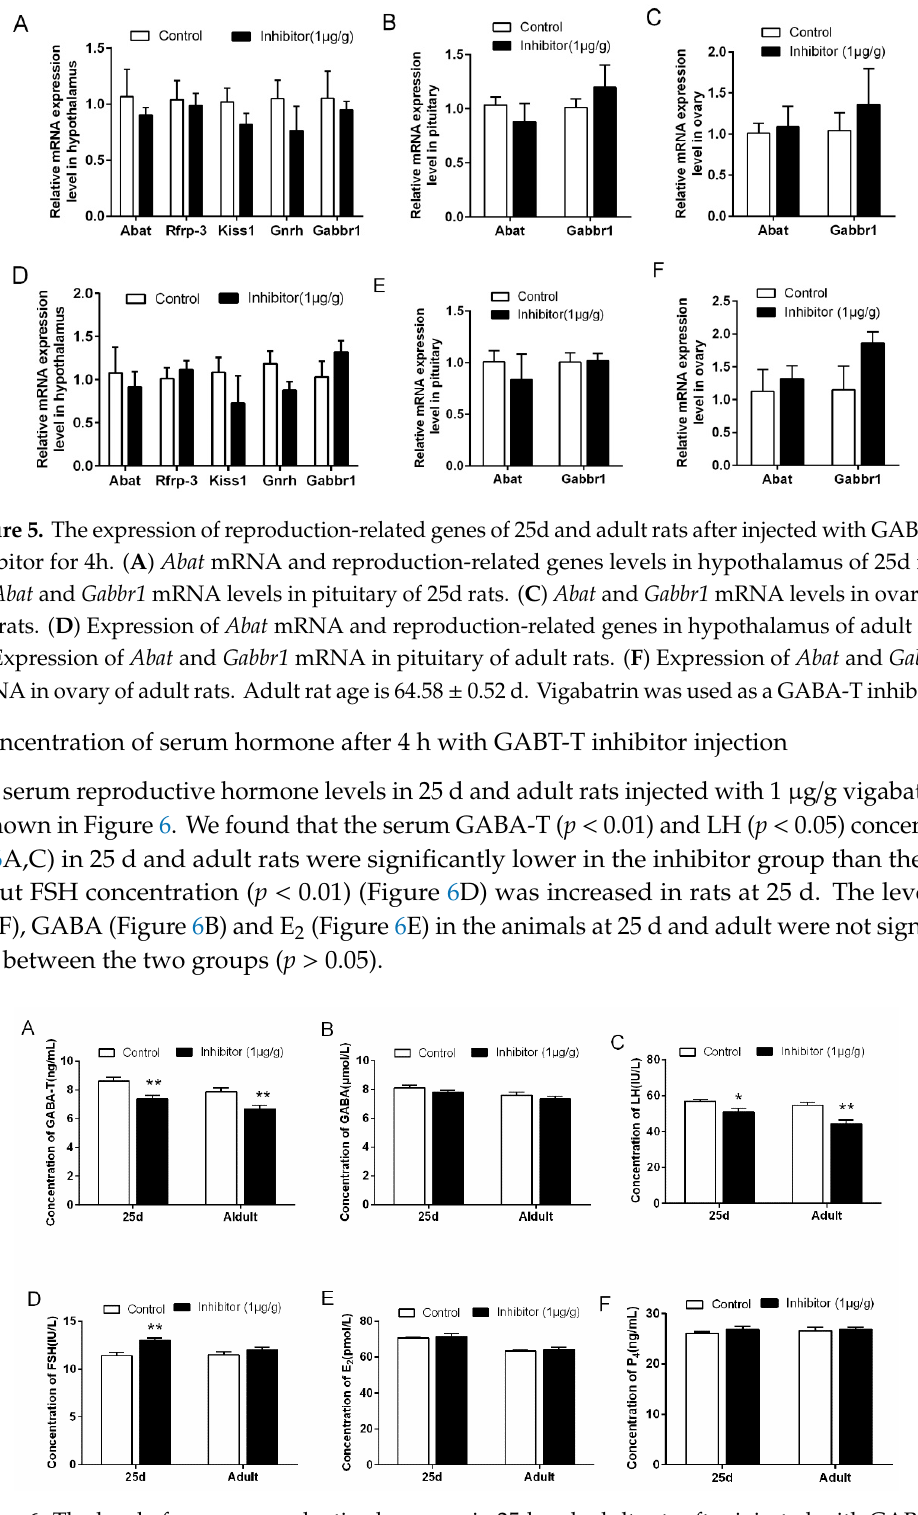
Figure 6. The level of serum reproductive hormone in 25d and adult rats after injected with GABA-T inhibitor for 4h. ( A ) The content of GABA-T in rat serum at 4h. ( B ) The content of GABA in rat serum at 4h. ( C ) The content of luteinizing hormone (LH) in rat serum at 4h. ( D ) The content of follicle-stimulating hormone (FSH) in rat serum at 4h. ( E ) The content of E2 in rat serum at 4h. ( F ) The content of P4 in rat serum at 4h. Adult rat age is 64.58 ± 0.52 d. ** indicates a very significant di ff erence ( p < 0.01); * indicates a significant di ff erence ( p < 0.05). Vigabatrin was used as a GABA-T